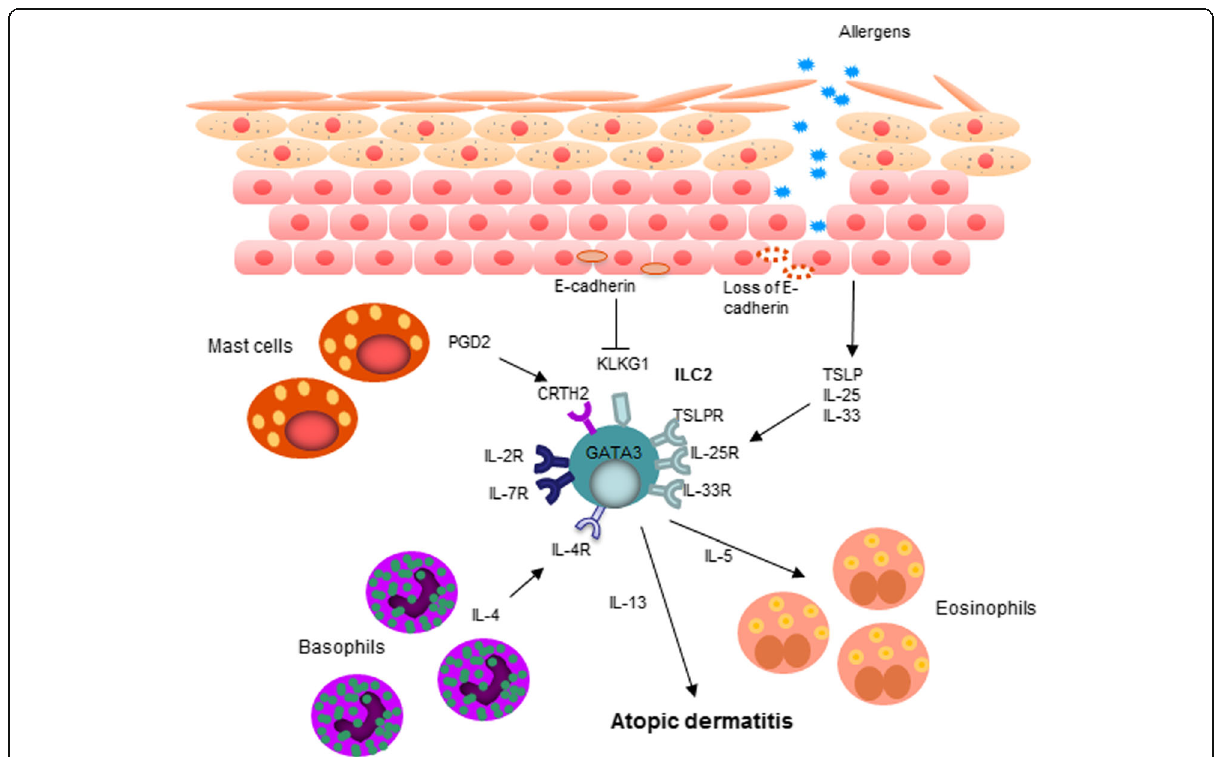
Fig. 2 Interplay among the barrier dysfunction, innate lymphoid cell (ILC)2, basophils, eosinophils, and mast cells. Barrier disruption leads to the production and release of epithelial-derived cytokines, namely, thymic stromal lymphopoietin (TSLP), IL-25, and IL-33. Upon ligation with the corresponding receptors on ILC2, TSLP receptor (TSLPR), IL-25 receptor (IL-25R, also known as IL17RB), and IL-33 receptor (IL-33R or ST2), ILC2 is activated to release Th2 cytokines, e.g., IL-5 and IL-13. In addition, IL-4 from basophils which are found in proximity to ILC2 in AD skin lesions can directly activate ILC2. PGD2, presumably from mast cell degranulation, also contributes to the recruitment of ILC2 into the skin as well as the induction of ILC2 Th2 cytokine production. In contrast, cell adhesion molecules, E-cadherin, on keratinocytes, are known to have an inhibitory effect on ILC2. Nevertheless, loss of E-cadherin is observed in FLG-deficient individuals. Therefore, skin inflammation is enhanced as there is an increase in stimulatory but a decrease in inhibitory